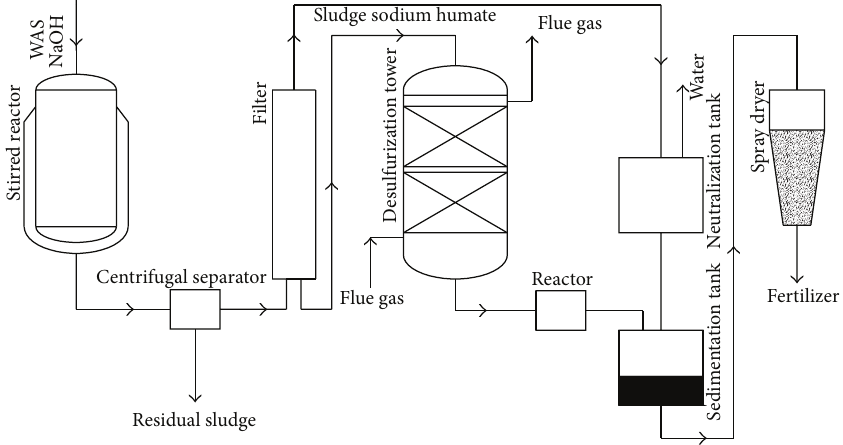
Figure 1: Simplified scheme of application of the SHA-Na for flue gas